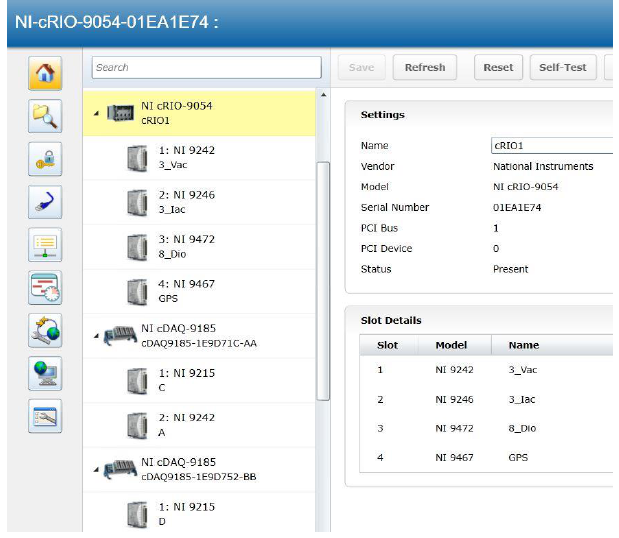
Figure 3. cRIO internal architecture with access to cDAQ.